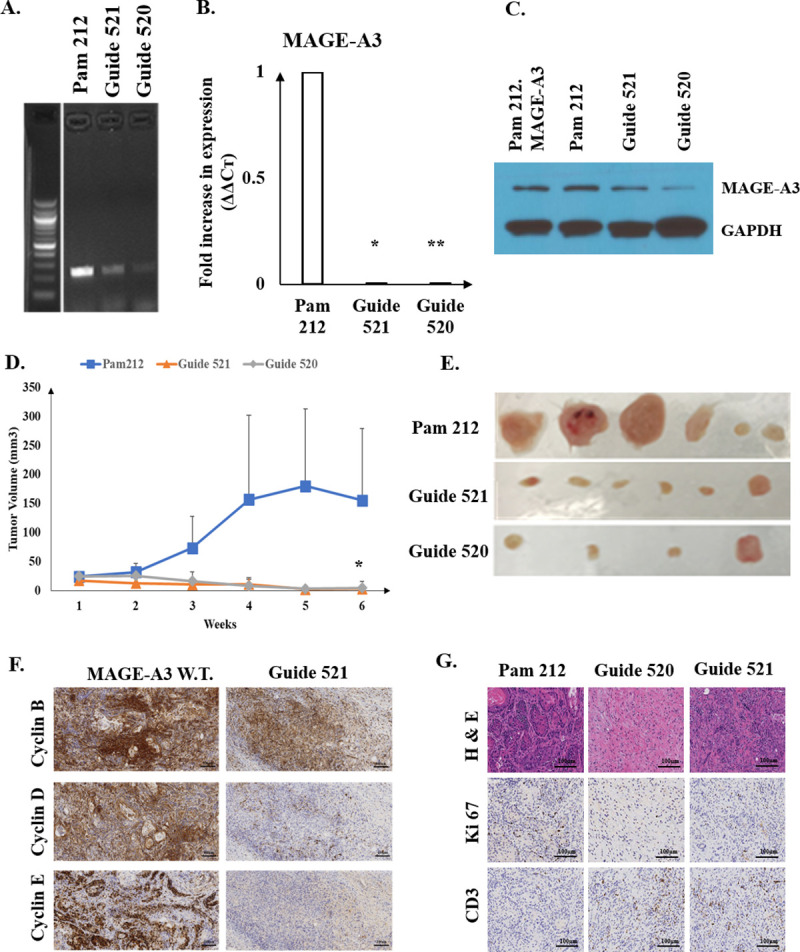
Knockout of MAGE-A3 expression in Pam 212 by CRISPR guide RNA 521 and 520 results in reduction of syngeneic tumor growth in Balb/c mice.(A) Validation of MAGE-A3 gene disruption was assessed by PCR. (B) RNA knockout was confirmed by qRT-PCR. Fold increase of MAGE-A3 expression in wild type Pam 212 was set to 1 ± 0. Fold changes in MAGE-A3 expression in Guide 521 and 520 were 0.0049 ± 0.00198 and 0.000535 ± 0.000209, respectively. Error bars indicate standard deviations. (C) MAGE-A3 suppression in Guide 521 and 520 was confirmed by Western Blot. Pam 212.MAGE-A3 represents Pam 212.pLKO.3G.MAGE-A3 as a positive control. (D) Volumes changes of Pam 212, Guide 521, and Guide 520 tumors in Balb/c mice over 6 weeks (n = 3 per group). The experiment was conducted twice with a total of 18 mice. At the 6th week, the volumes of syngeneic tumors of Guide 520 and 521 were reduced to 4.8 ± 11.2 mm3 and 3.2 ± 5.3 mm3 compared to Pam 212 tumors (155.3 ± 124.3 mm3). (E) Images of tumors obtained from mice after 6 weeks of growth in Balb/c mice. NOTE: Guide 520 yielded total tumor regression in 2 mice, so these tumors are not displayed. (F) Immunohistochemistry analysis of cyclin B, cyclin D, and cyclin E expression in MAGE-A3 wild type (W.T.) and Guide 521 tumor tissue. Scale bars indicate 100 μm. (G) Immunohistochemical assessment of MAGEA3, Ki67, and CD3 expression in Pam 212, Guide 520 and Guide 521 cSCC tumor tissue. Scale bars indicate 100 μm. * and ** represent p<0.05.